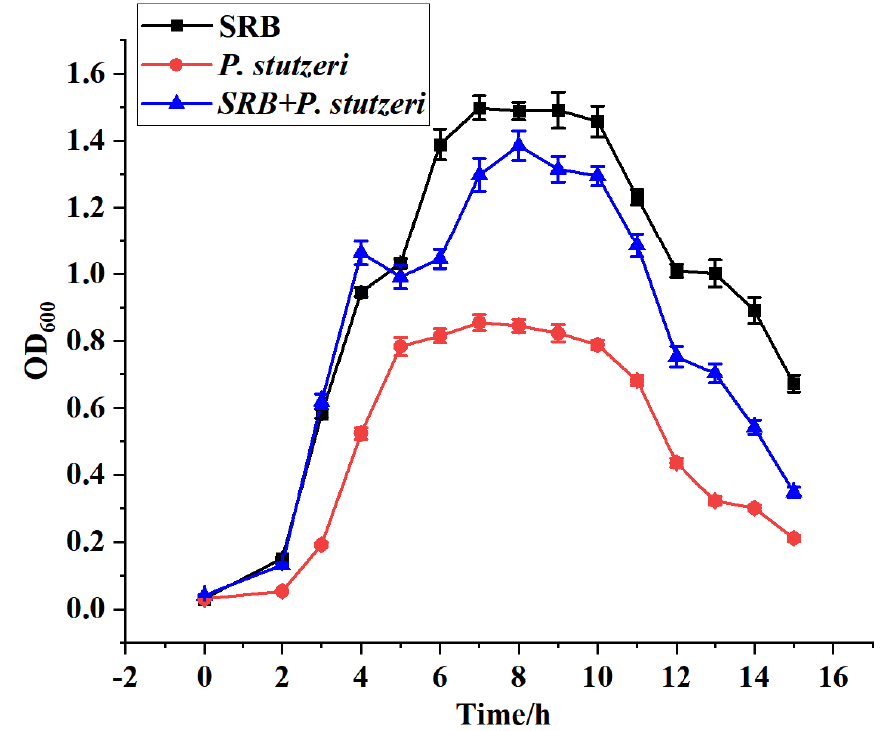
Figure 5. Growth curves of SRB, P. stutzeri and co-culture of P. stutzeri and SRB.